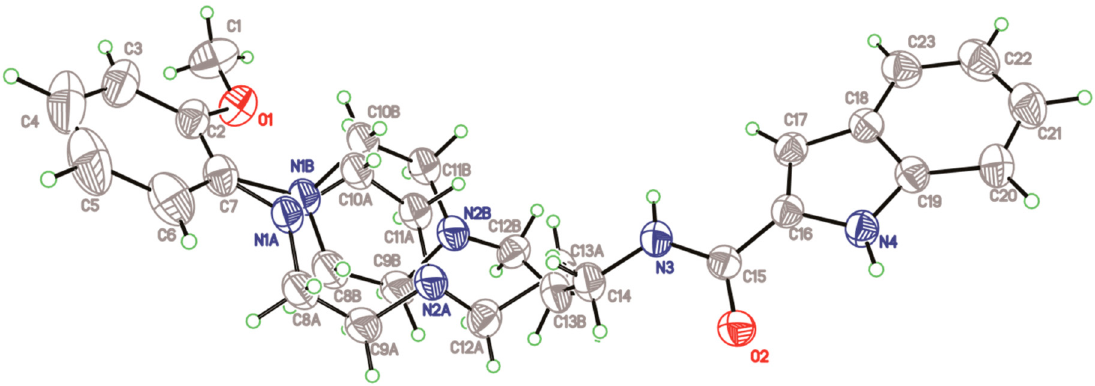
Figure 6. Crystallographic structure of compound 3 . Displacement ellipsoids are drawn at the 30% probability level.